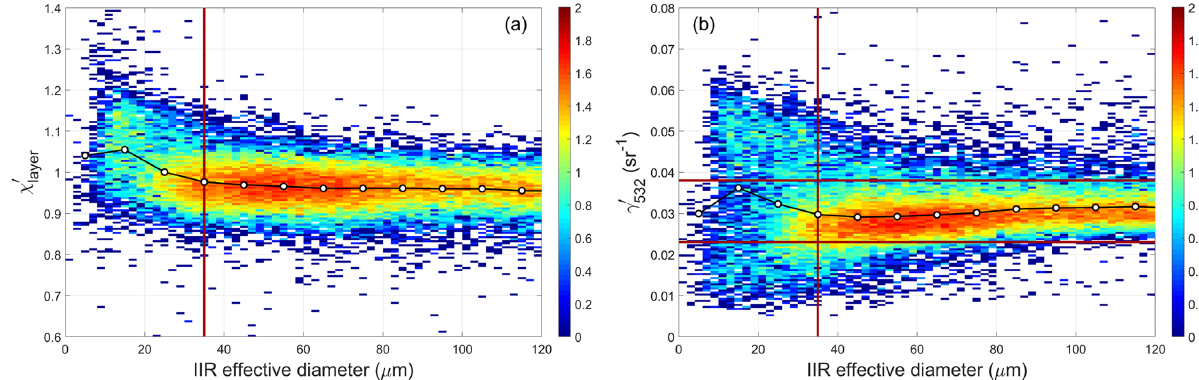
Figure 10. (a) χ (cid:48) and (b) γ (cid:48) as functions of IIR-derived effective particle size for all nighttime calibration quality clouds detected by layer 532 the V3 1064nm calibration scheme during October 2010. The filled circles in each panel represent median values of the distributions. The horizontal red lines in panel (b) show γ (cid:48) limits of 0.023sr − 1 (lower line) and 0.038sr − 1 (upper 532